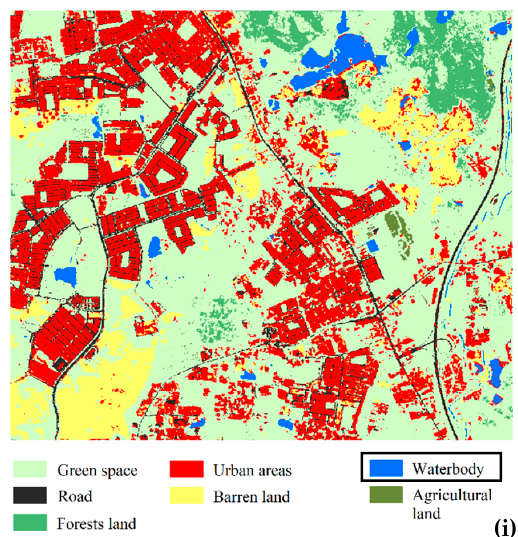
Figure 8. (a) Second test dataset (Ipoh area), (b) Ground truth map of the second test area, and Figure 8. ( a ) Second test dataset (Ipoh area), ( b ) Ground truth map of the second test area, and classification results of the testing area with different unseen classes, (c) green space, (d) urban areas, classification results of the testing area with di ff erent unseen classes, ( c ) green space, ( d ) urban areas, ( e ) road, ( f ) agricultural land, ( g ) forest lands, ( h ) barren land, and ( i ) Table 12. Retrieved labels for the unseen classes for the second test area (Ipoh).